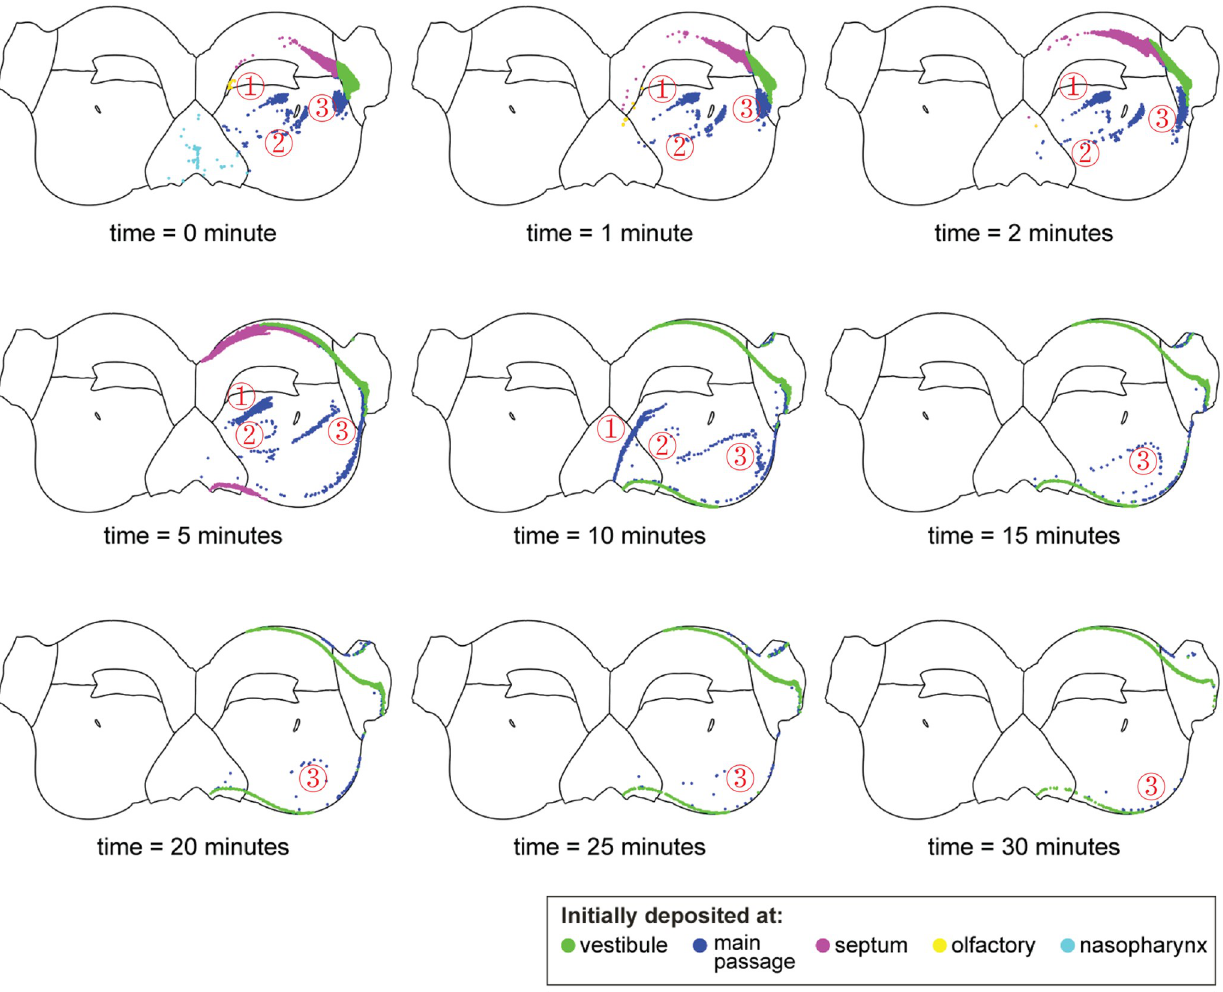
Fig 8. Post-deposition particle transport over time. The particles were coloured by deposition